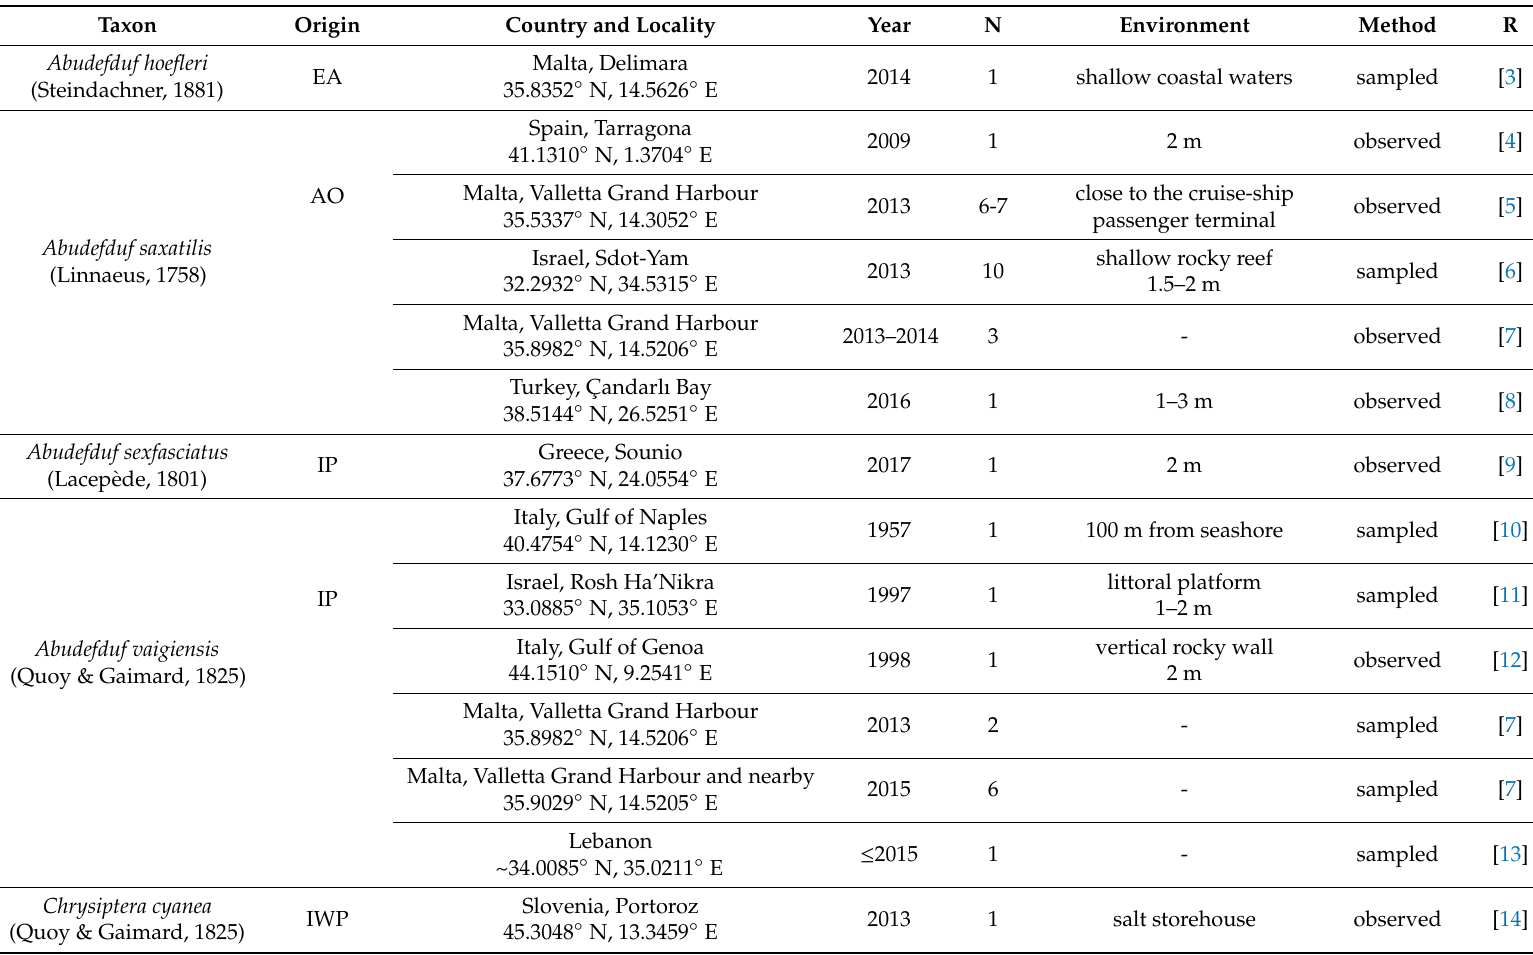
Table 1. Records of alien and cryptogenic taxa belonging to the family Pomacentridae Bonaparte, 1831 from the Mediterranean Sea, with origin, country and locality with coordinates, year of first sighting, number of specimens (N), environment, method of observation, and references (R) as listed in literature (see also Figure